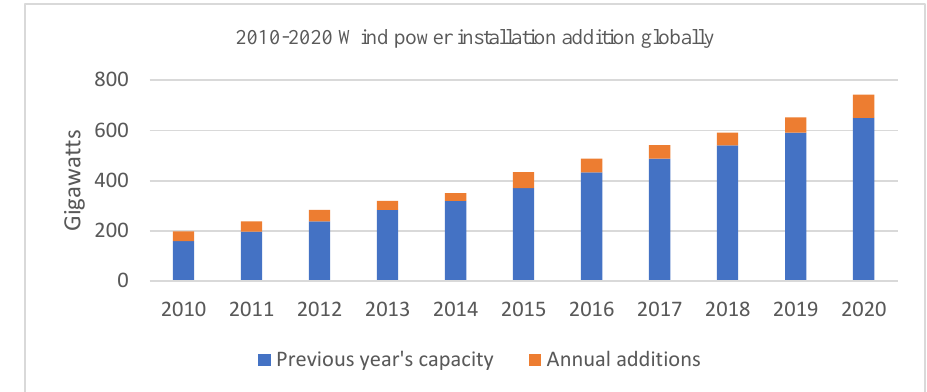
Figure 8. Wind power global capacity and annual additions [55].